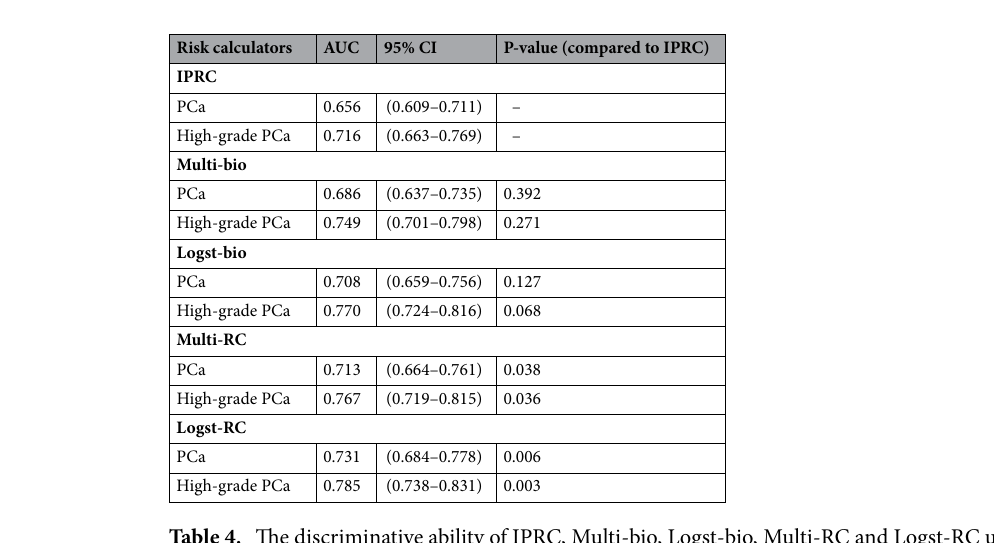
Table 4. The discriminative ability of IPRC, Multi-bio, Logst-bio, Multi-RC and Logst-RC using the areas under the curve (AUC) and 95% confidence interval of the calculated probabilities. The p-values indicate if each model significantly improve the